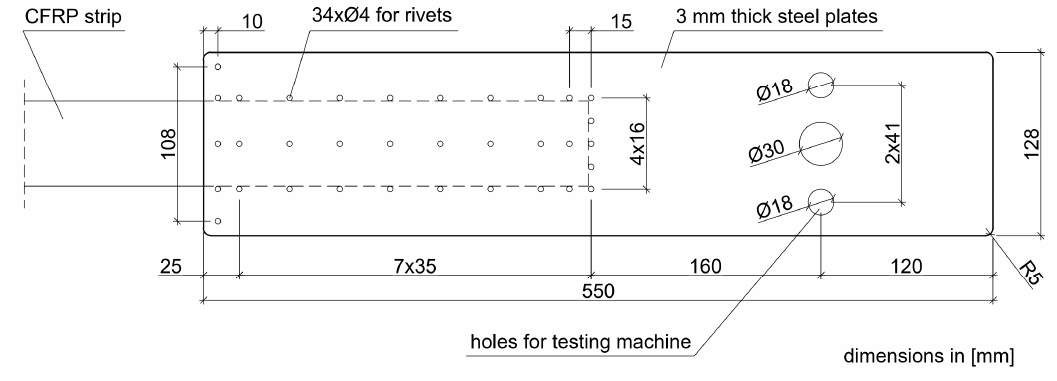
Figure 3. Arrangement of the rivets, S3N–S5N, series’ specimens (NPS II). Table 1. Differences between anchorages used in the NPS I and NPS II systems.